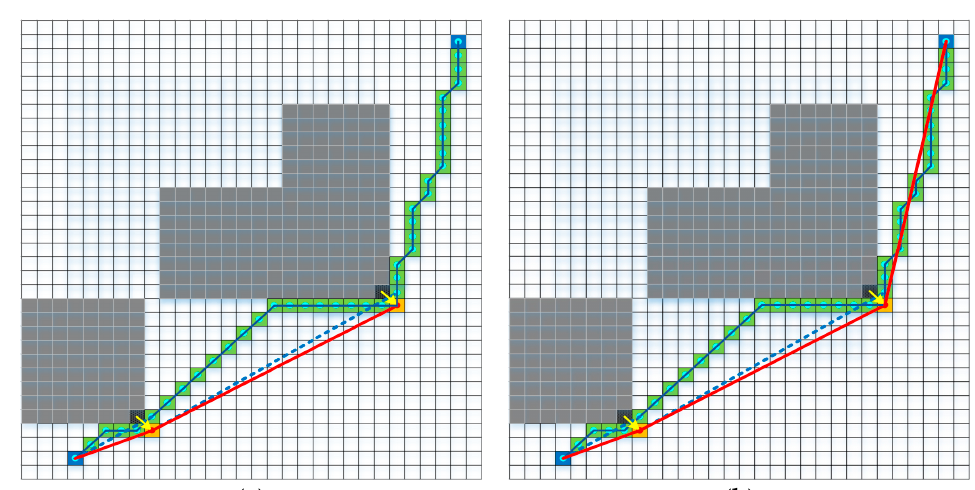
Figure 2. A detoured and long improved A* path (green path) is pruned. For each node of the path, its visibility to the last waypoint of the pruned path (red path) is checked. The blocking voxels (black voxel) are pushed and appended as new waypoints (orange voxel). Sub-figure ( a ) shows the way to prune when it is not visible, and sub-figure ( b ) shows the way to prune when it is visible.